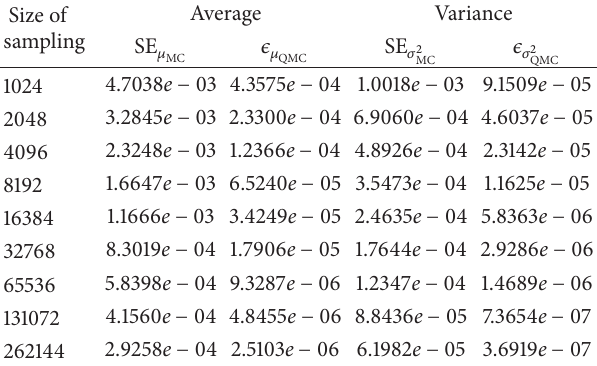
Table 17: Errors of the average and variance computed by MC and QMC for the Vasicek interest rate model 𝑅 𝑇 at time 𝑇 = 1 , with parameters 𝛼 = 0.1 , 𝛽 = 2 ⋅ 10 −5 , 𝜎 = 15 %, and 𝑅 0 = 110